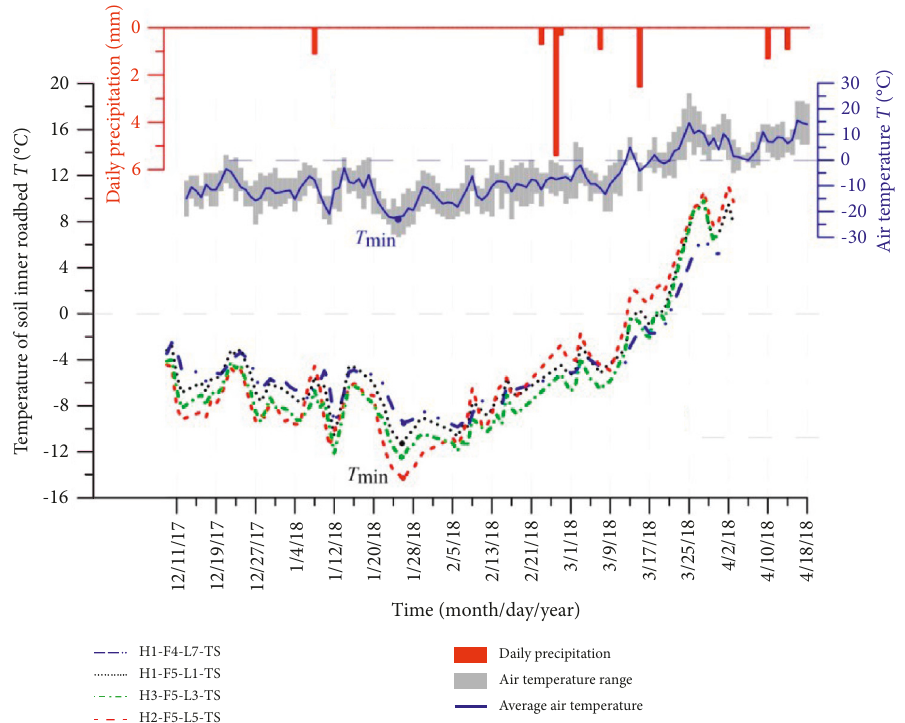
Figure 6: Curves of soil temperature in the F5 and F4 layers of the roadbed under climatic